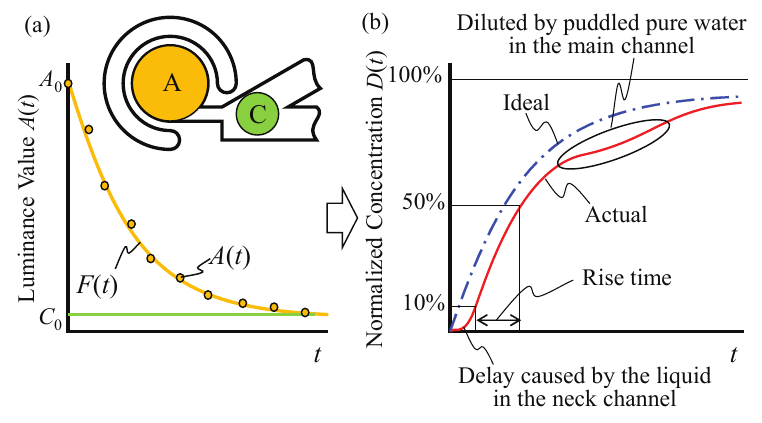
Evaluation method of the mixing speed: ( a ) measured luminance value and ( b ) normalized